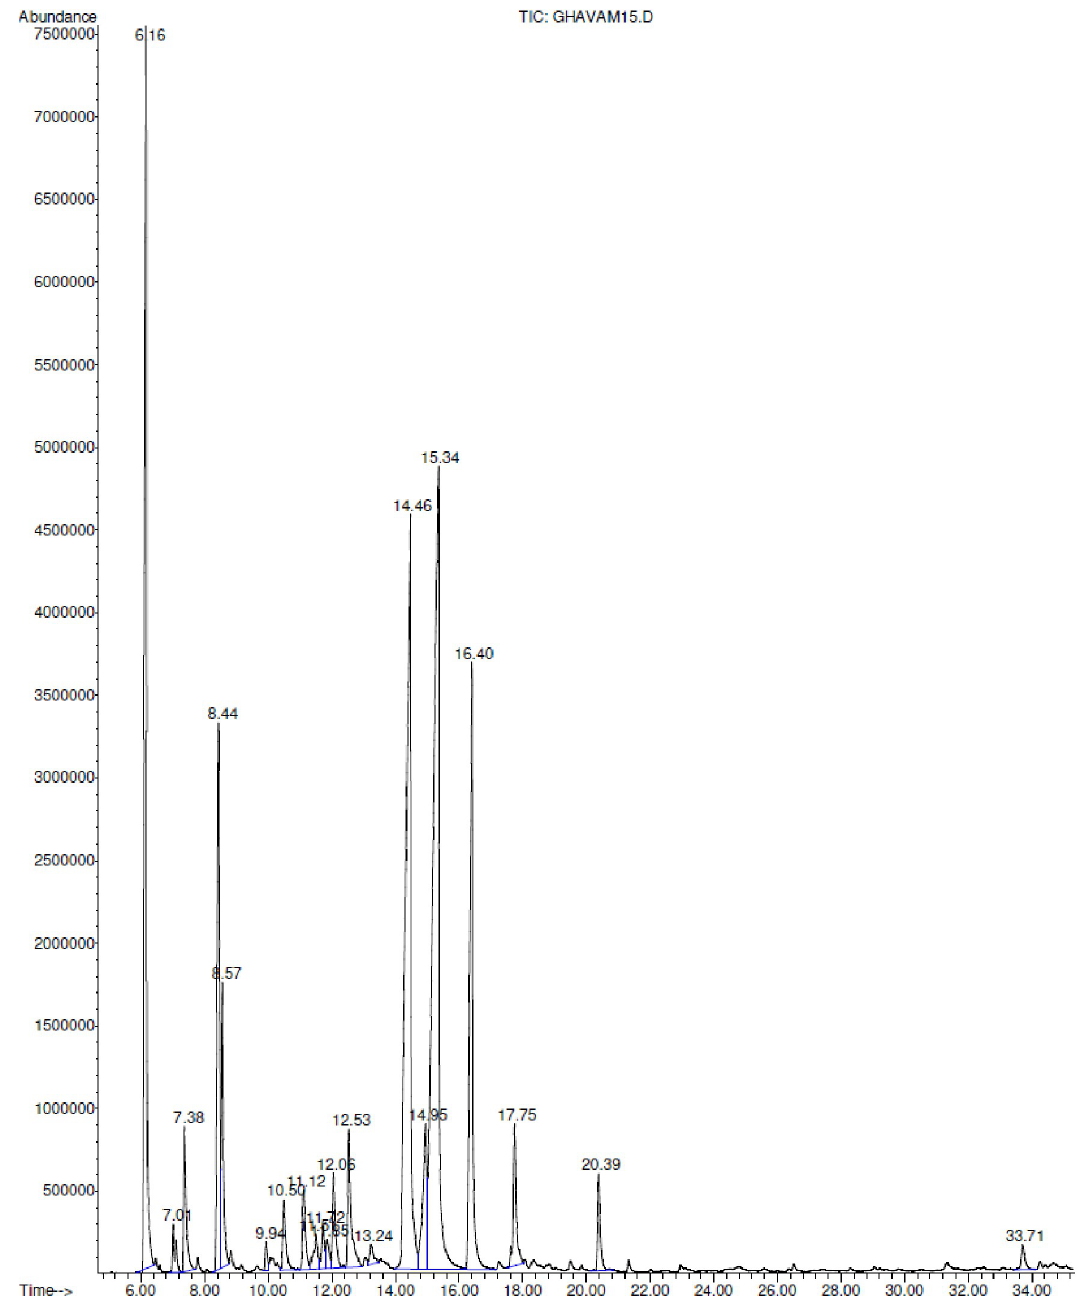
Fig 1. GC-MS chromatogram of essential oil of D . kotschyi